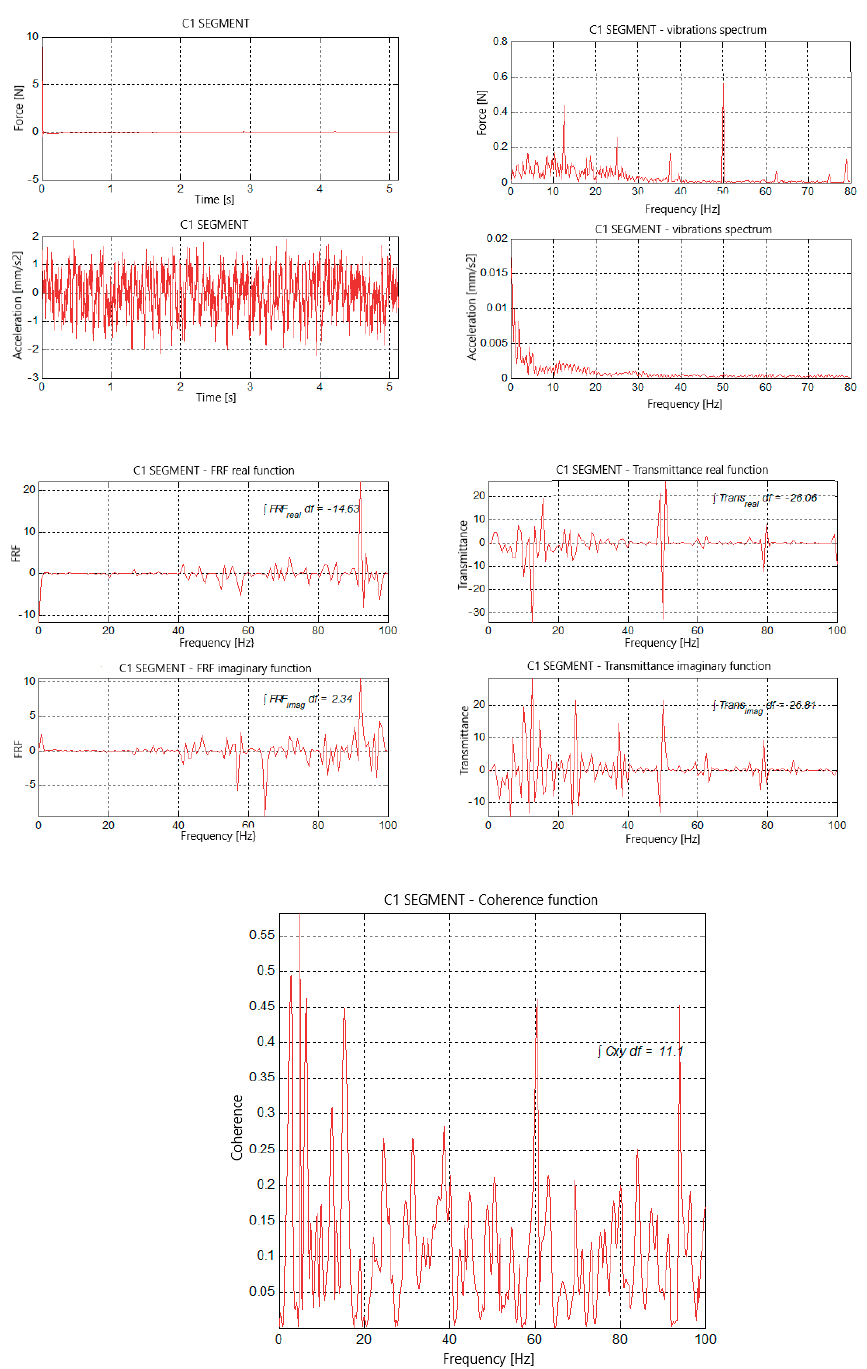
Figure 9. Vibration measures results for C1 segments. The vibration signal measurements of tested CD1 segments are shown on the X-axis.